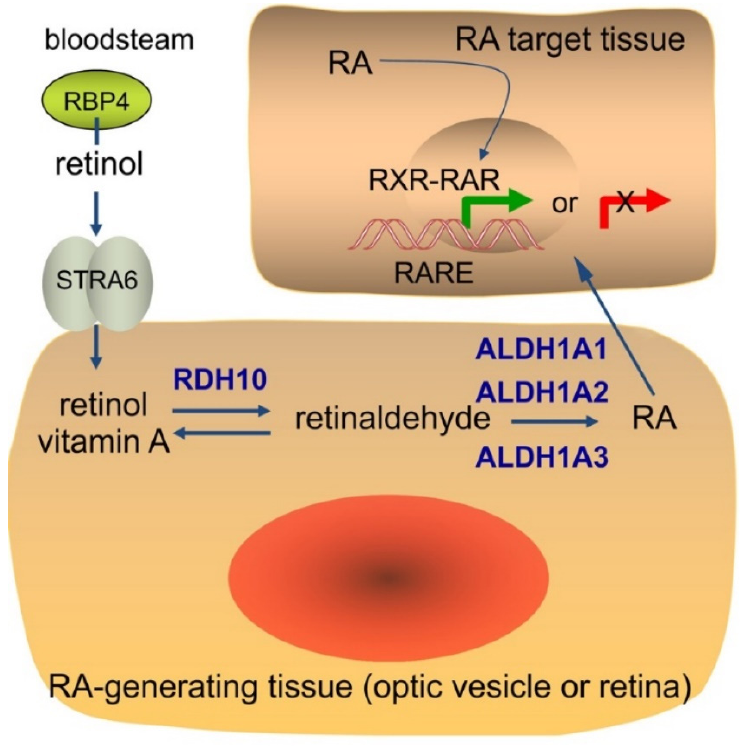
Figure 1. Generation of RA and control of transcriptional activation or repression of target genes.